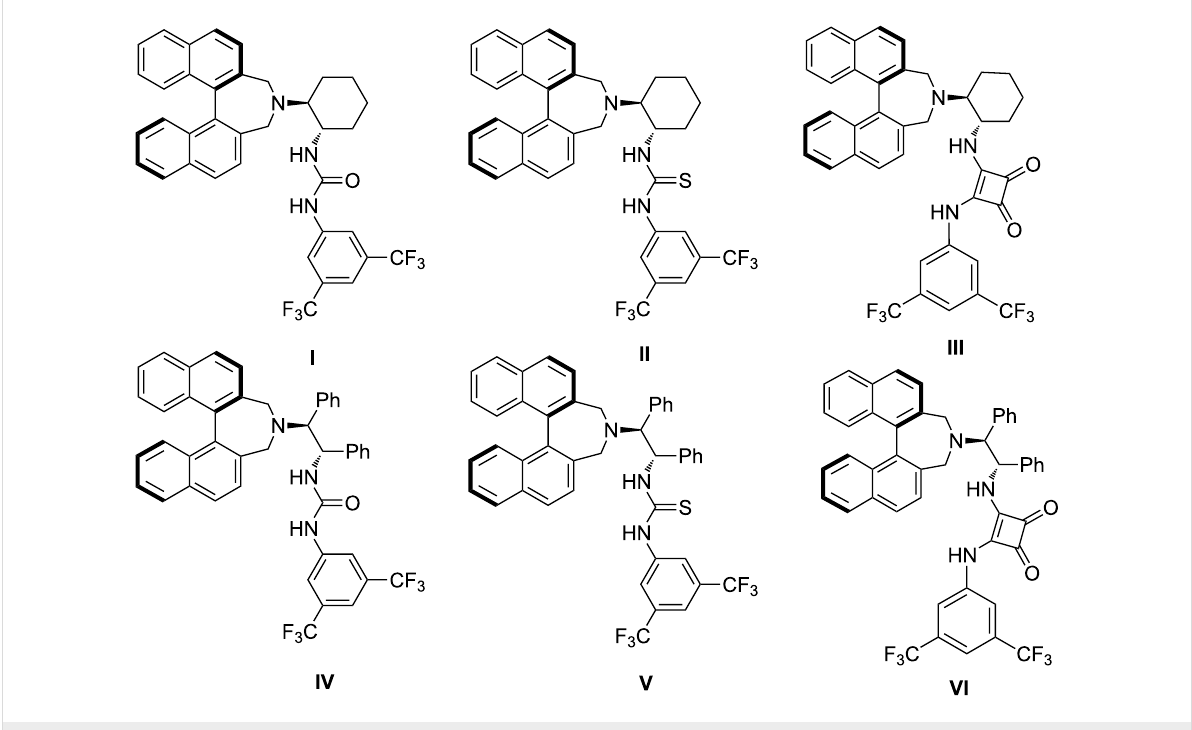
Figure 1: Structure of chiral bifunctional